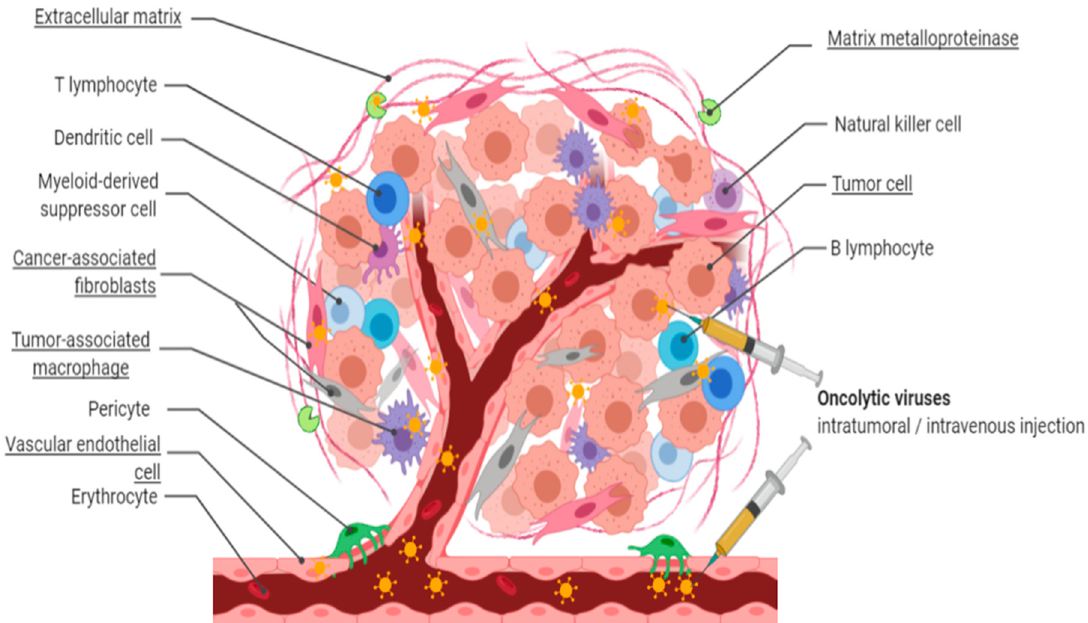
Figure 1. Simultaneous tumor and stroma targeting upon in situ oncolytic virus administration. In situ administration of natural, bioselected, or genetically engineered oncolytic viruses (OVs) results in targeting of tumor cells as well as stroma components, including heterogeneous cancer-associated fibroblasts, extracellular matrix, tumor vasculature, and tumor-associated macrophages. As a result, OV penetration and replication are increased, leading to enhanced tumor killing and anti-tumoral immune activity.